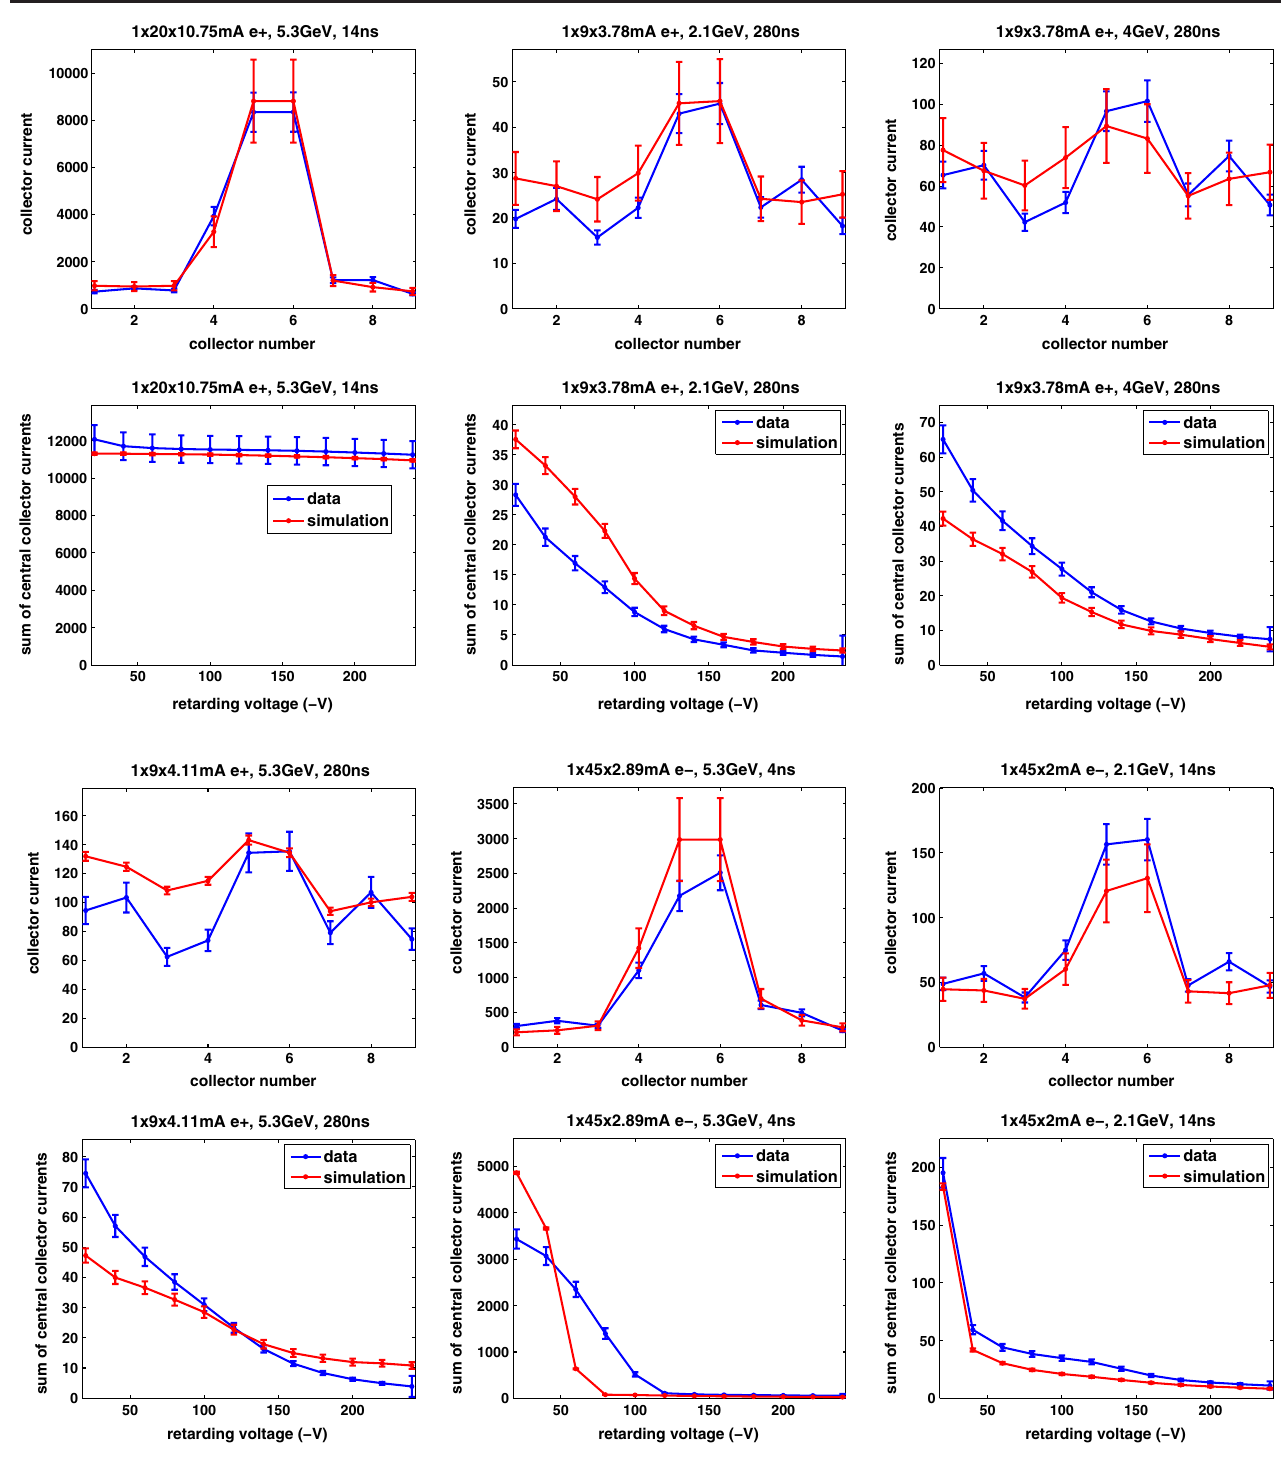
FIG. 8. Comparison of Q15WAl RFA data and simulation, using best fit parameters (Table VII), conditions 7 – 12 (Table VI). The RFA is “ thin ” style (Table II). The top plots show the total signal across the 9 RFA collectors (with þ 50 V on the grid); the bottom plots show the signal in the central three collectors vs retarding